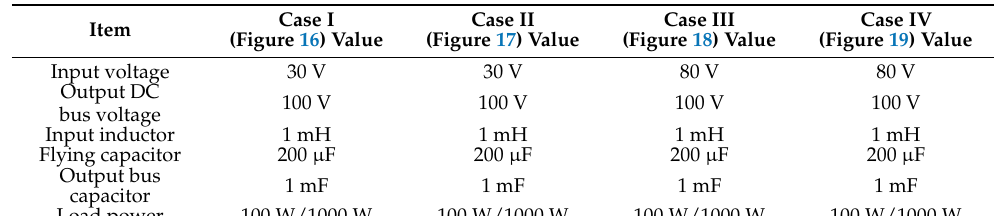
Table 1. The parameters of the different simulation cases.